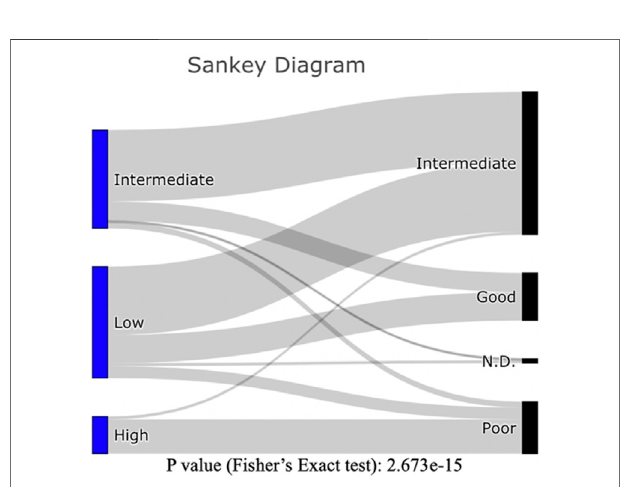
FIGURE 5 | Sankey Diagram: Counts of patients in our three molecular subgroups (Left), as classi fi ed by established cytogenetic risk levels (Right). Counts of patients can be found in Supplementary Table